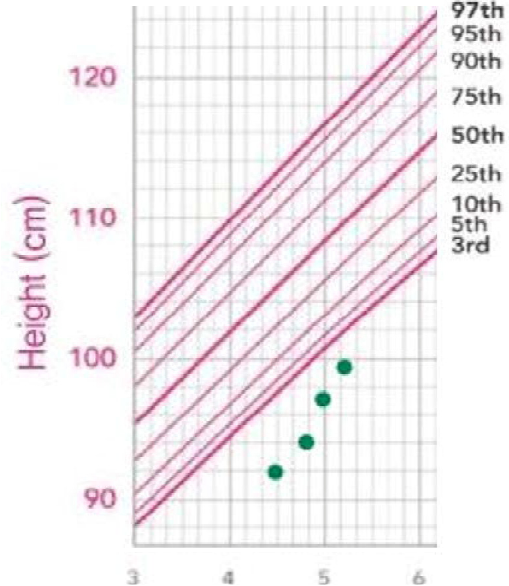
Figure 3. Growth curve of the patient from initial diagnosis to treatment period. The height of the patient was below the 3rd percentile. Modified from Kim, J.H et al. The 2017 Korean National Growth Charts for children and adolescents: development, improvement, and prospects. Korean J.